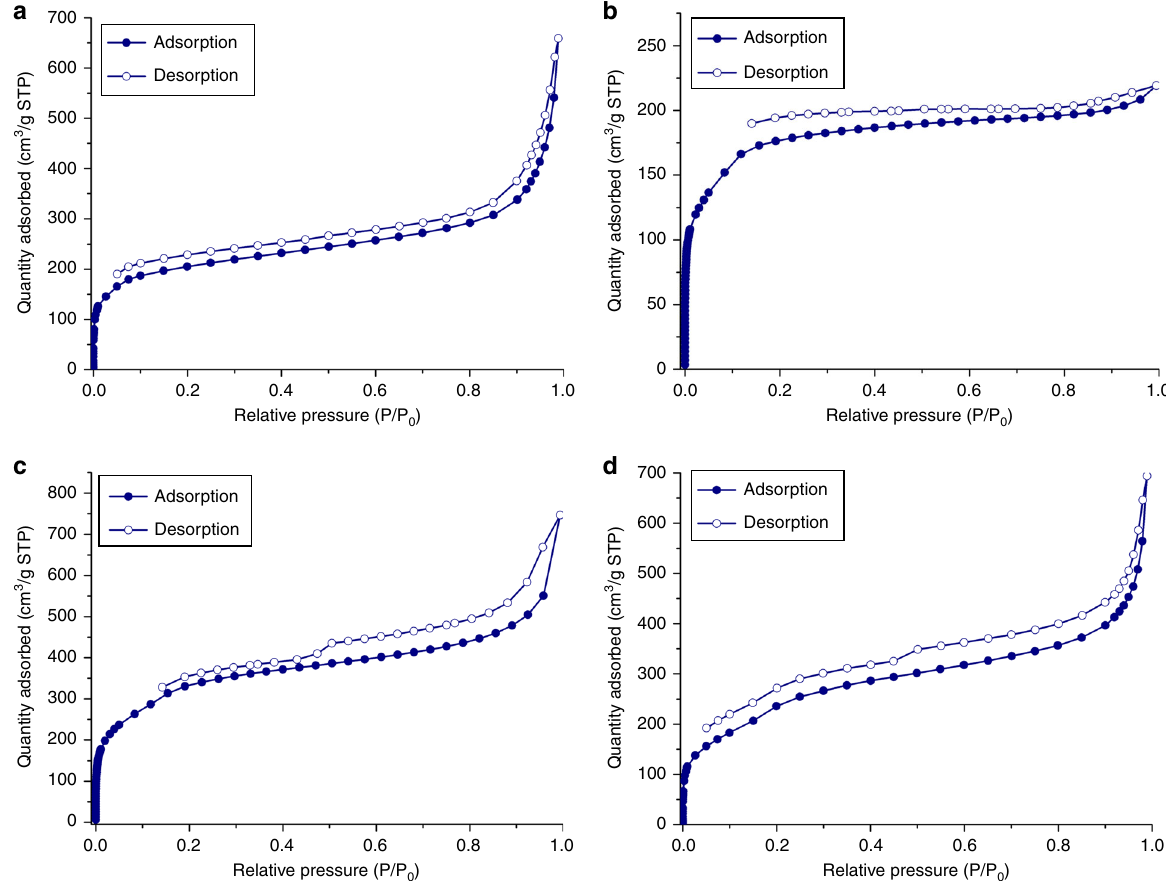
Fig. 9 Porosity measurements. N 2 adsorption − desorption isotherms (77 K) of a Tri-COF-DAB, b Tetra-COF-DAB, c Tri-COF-BZ, and d Methods Synthesis of Tri-COF-DAB . TPM (30.0 mg, 0.043 mmol) and 1,4-diaminobenzene (DAB, 14.1mg, 0.130 mmol) were added into a mixture of 1,4-dioxane (0.75 mL), mesitylene (0.75 mL), and acetic acid (aq. 6M, 0.15mL) in a glass ampoule. The ampoule was sealed under vacuum after three freeze-pump-thaw cycles. Then the mixture was heated at 120 °C without disturbance for 72 h to afford a yellow solid at the bottom of the tube. After being cooled to room temperature, the solvent was